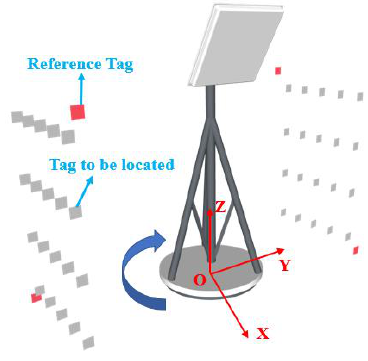
Figure 5. Two-dimensional (2D) deployment.